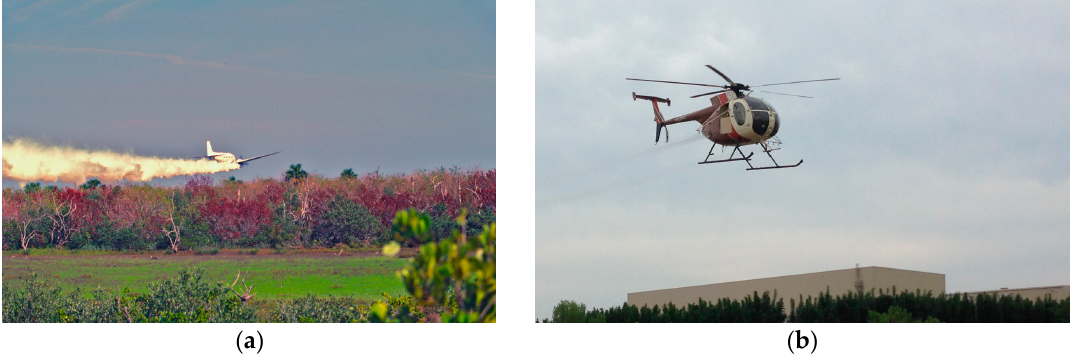
Figure 2. ( a ) An aerial adulticiding mission using fogging (Courtesy of G. Alan Curtis); ( b ) An aerial adulticiding mission using ultra-low volume (ULV) (Courtesy of Mark D. Latham).